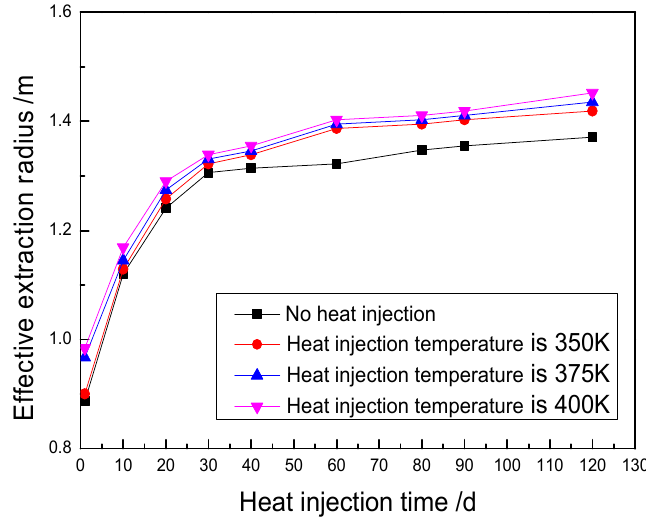
Figure 10. Effect of heat injection temperature on effective extraction radius.